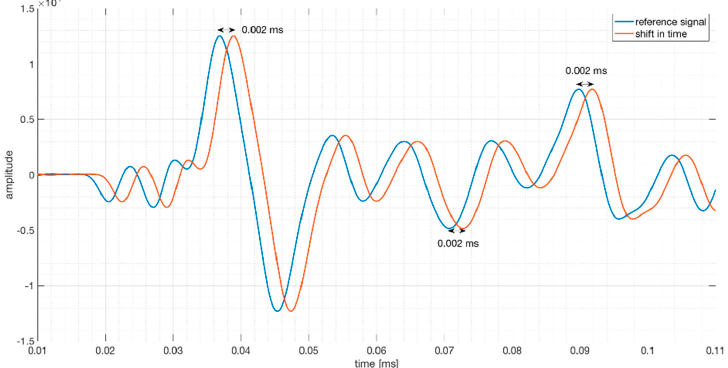
Figure 4. Two signals with a shift of 0.002 ms in time.